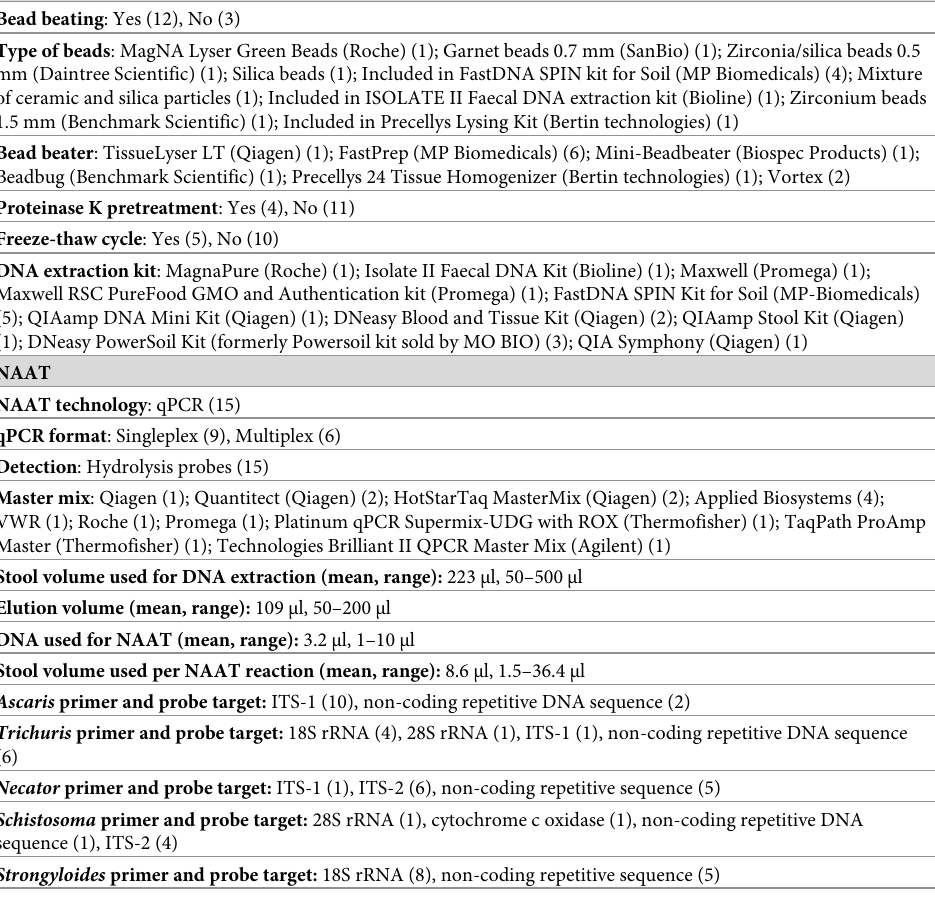
Table 4. Overview of the different DNA extraction and NAAT protocols used in the HEMQAS pilot study. The number between brackets corresponds to the number of laboratories. ITS-1, intergenic transcribed spacer-1; ITS-2, intergenic transcribed spacer-2; 18S rRNA, 18S ribosomal ribonucleic acid; 28S rRNA, 28S ribosomal ribonucleic acid. DNA